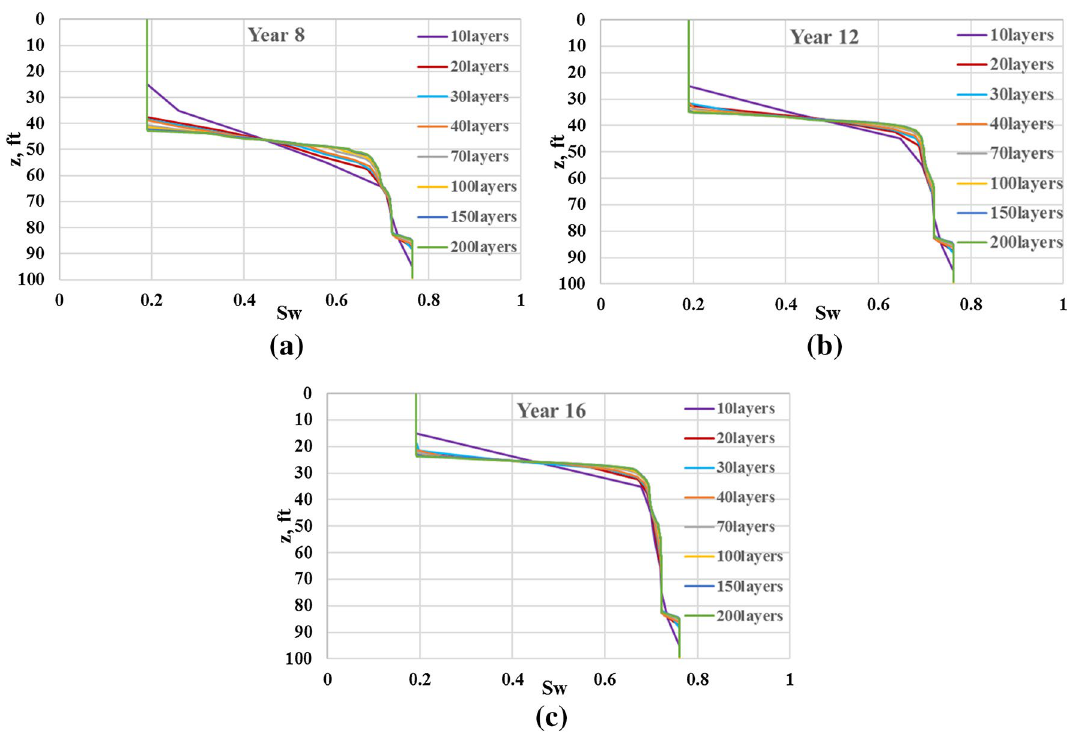
Fig. 12 Water saturation profile at near wellbore along vertical depth for models with different layers at three different production times